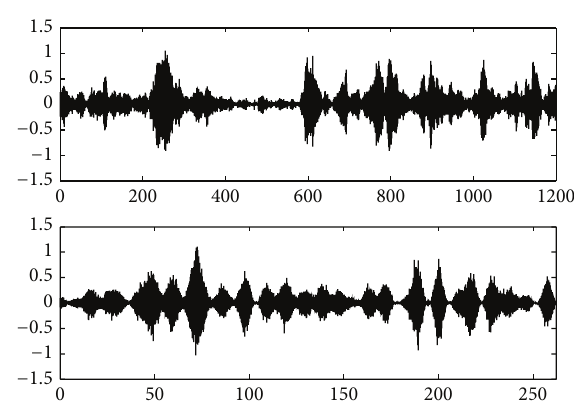
Figure 5: PDF of the running RMS using different number of bins and Rayleigh distribution.